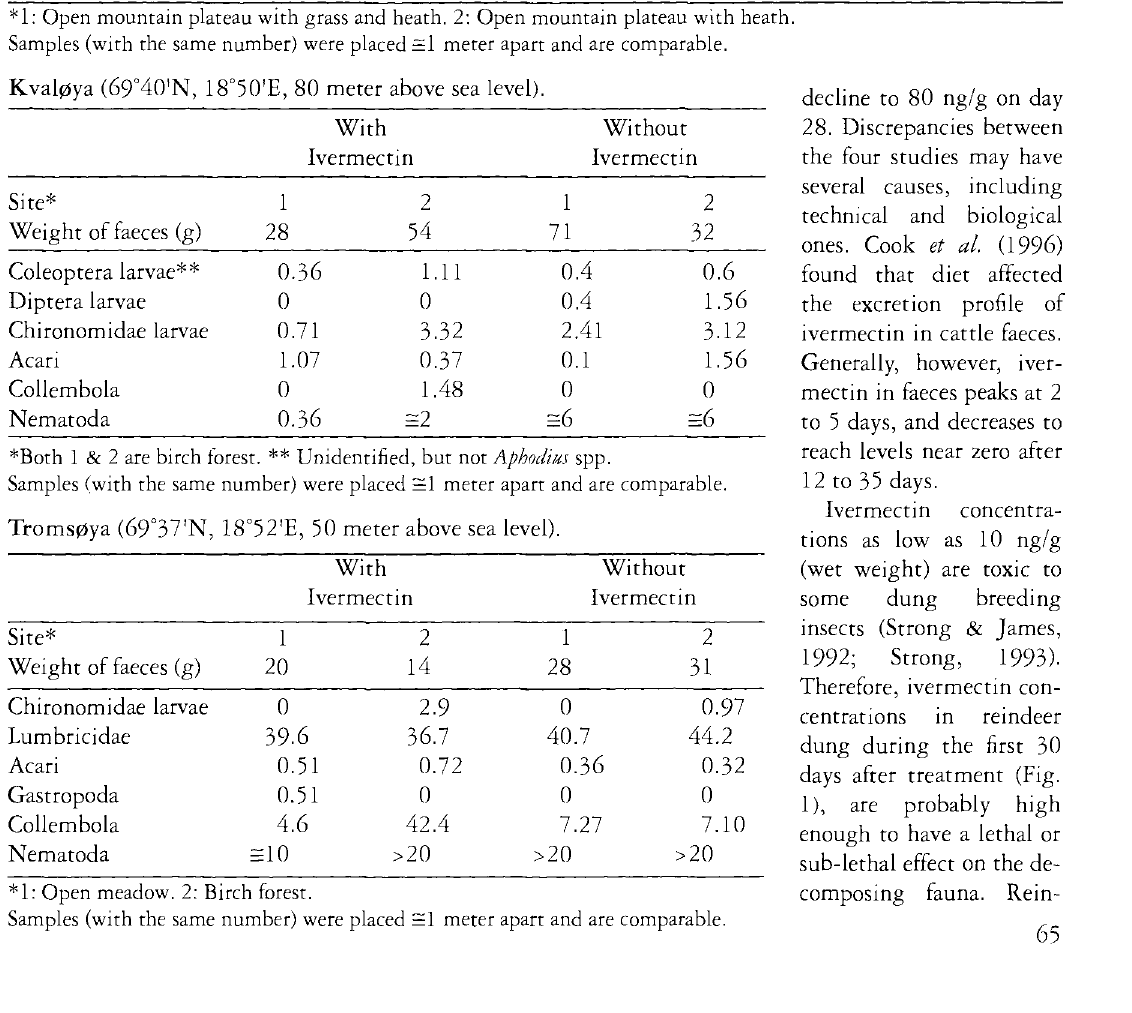
to 5 days, and decreases to